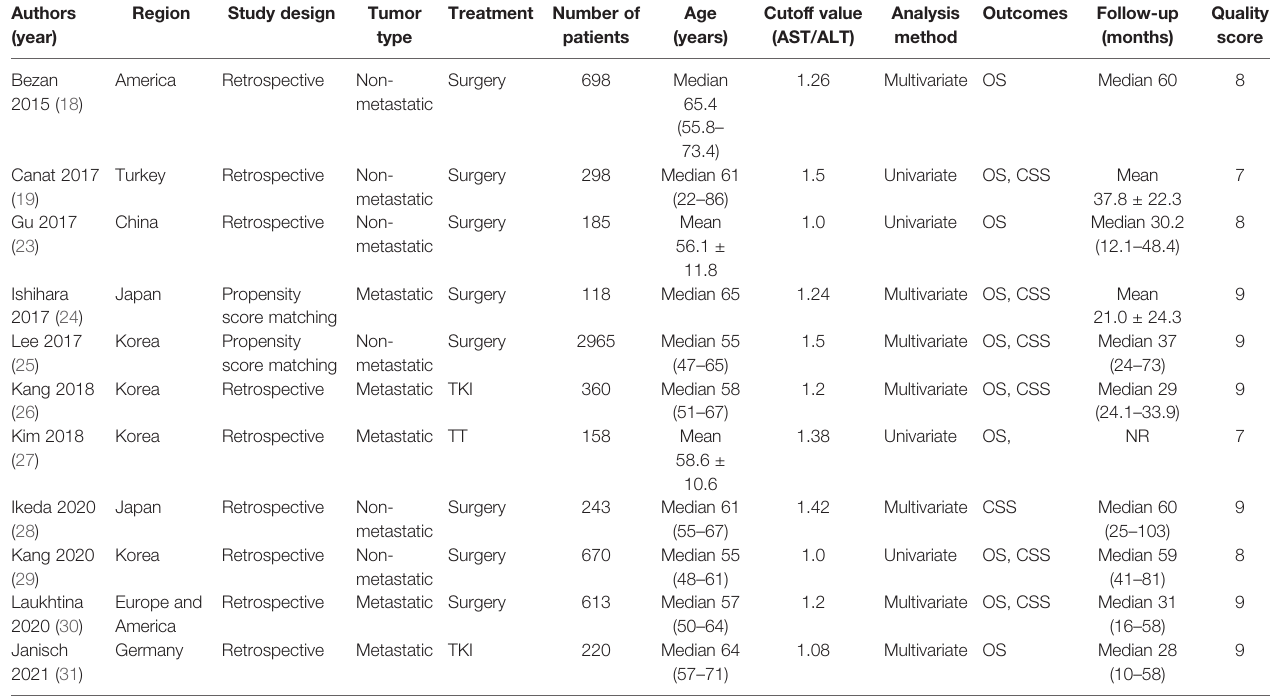
TABLE 1 | Baseline characteristics of include studies and methodological